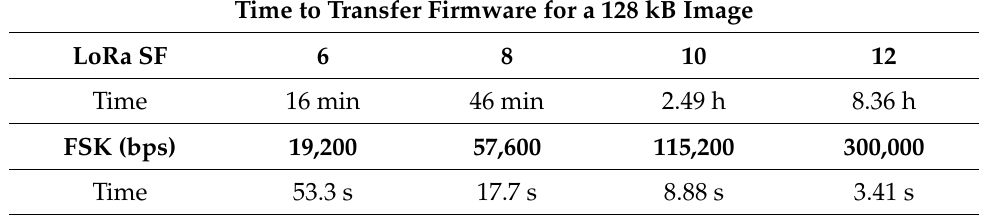
Table 1. The time required to update a 128 kB firmware